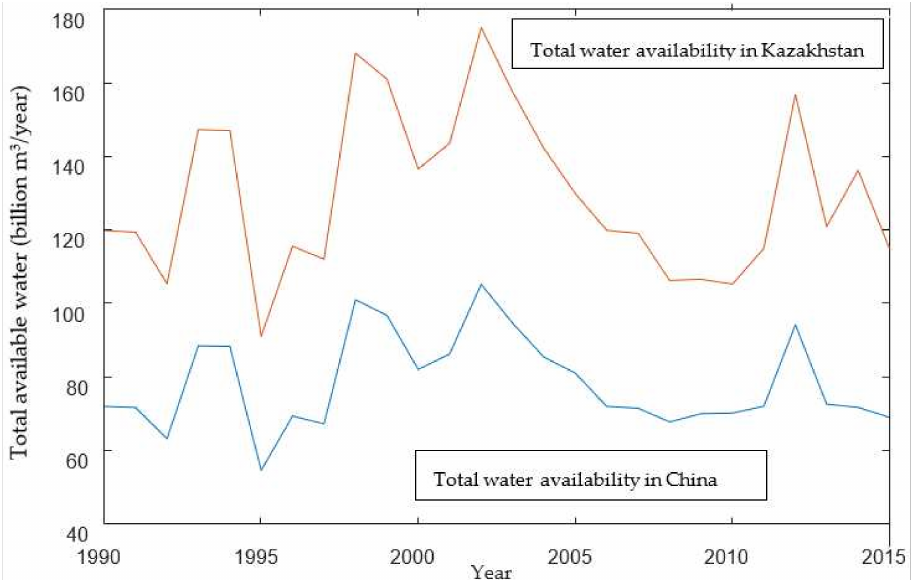
Figure 5. Total water availability in the study area without virtual water transfer.